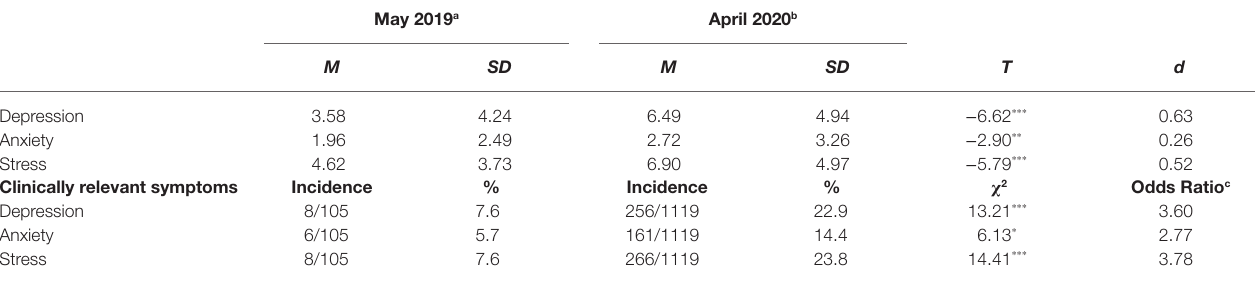
TABLE 6 | T -tests and Chi-square tests comparing DASS-scores between flying cabin crews sample May 2019 and April 2020.